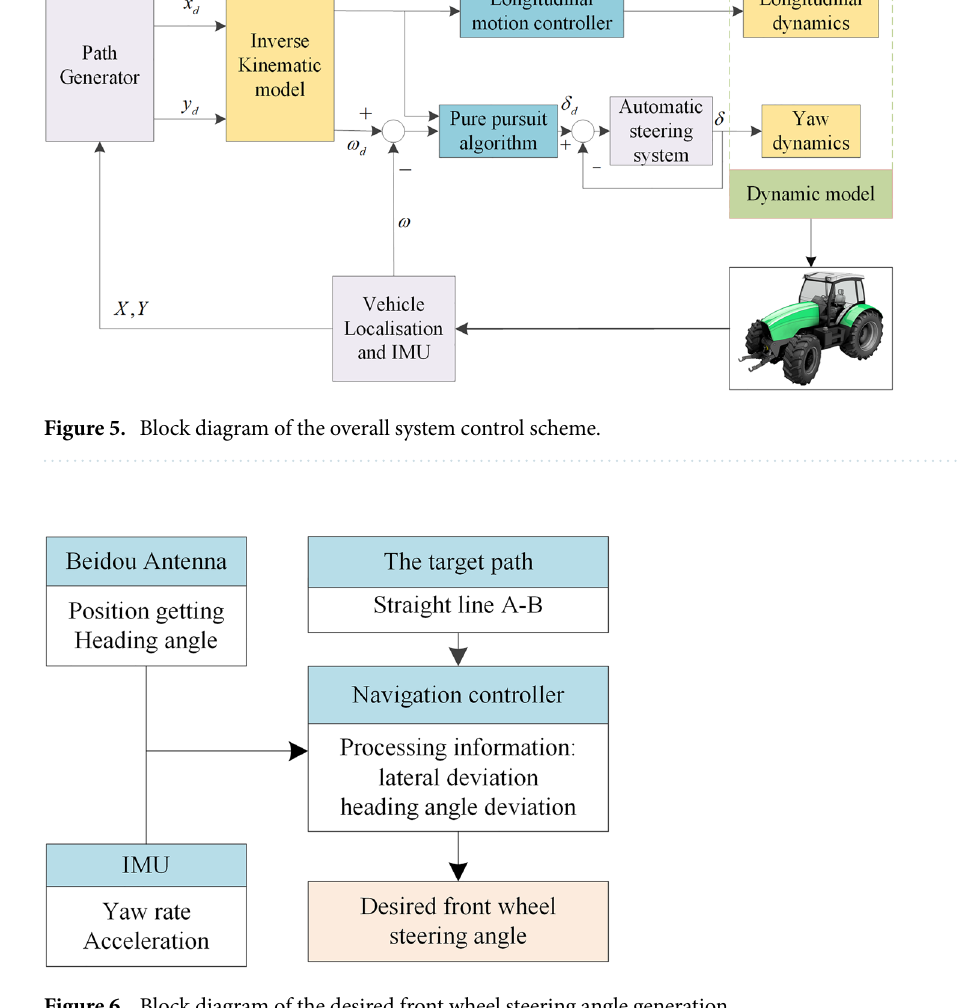
Figure 6. Block diagram of the desired front wheel steering angle